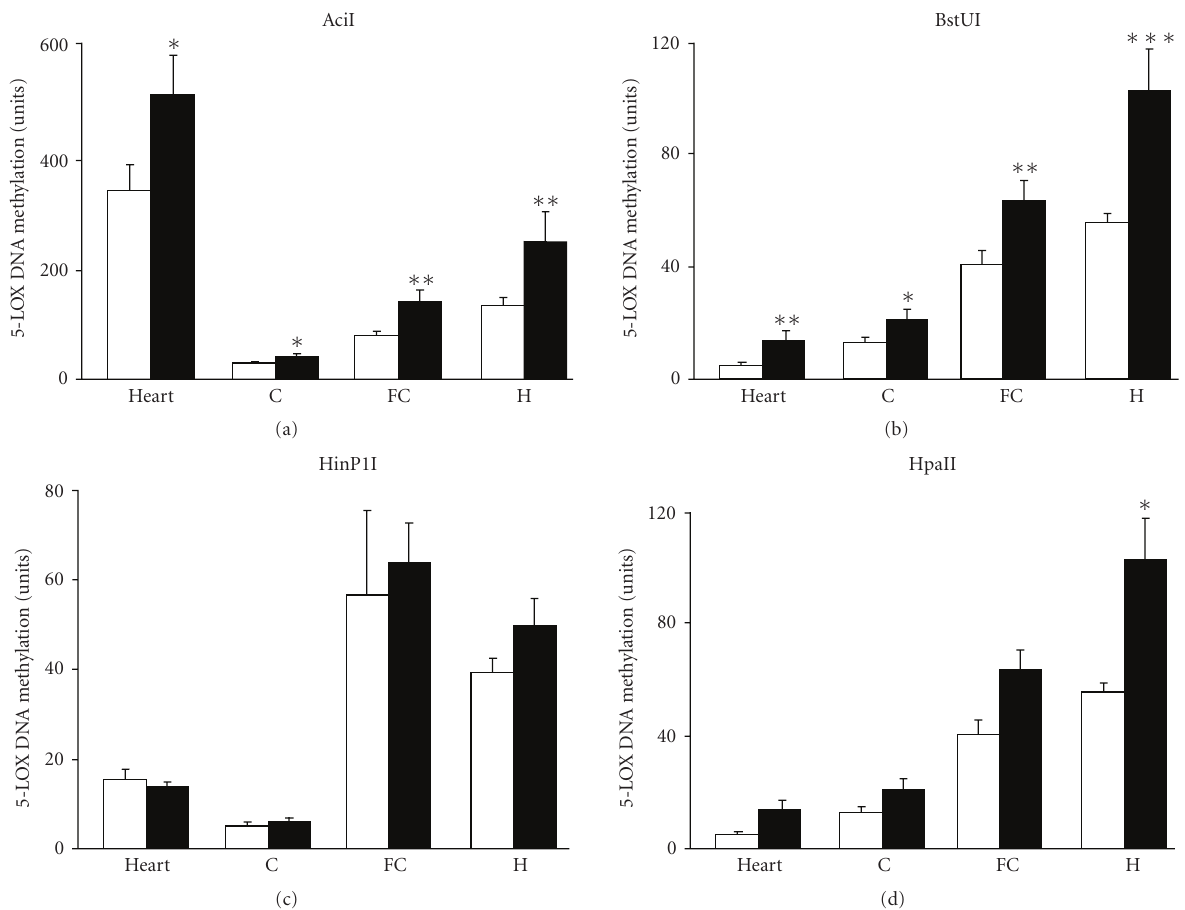
Figure 4: The e ff ect of aging on 5-LOX DNA methylation in the region promoter-5 (cid:2) UTR. The methylation-sensitive endonuclease assay with the four endonucleases—AciI, BstUI, HinP1I, and HpaII—was performed as described in the text and indicated in Figure 1. The heart and brain (C: cerebellum, FC: frontal cortex, H: hippocampus) tissue samples were obtained from 2-month-old mice (open bars) and 22- month-old mice (closed bars). The results are expressed as units (the coe ffi cient of variation values multiplied by a factor of 1000, see text for details) and shown as mean ± S.E.M (heart, C, and H: n = 5; FC: n = 10). ∗ P < . 05, ∗∗ P < . 01, and ∗∗∗ P < . 001 versus the corresponding values in samples from 2-month-old mice ( t -test).